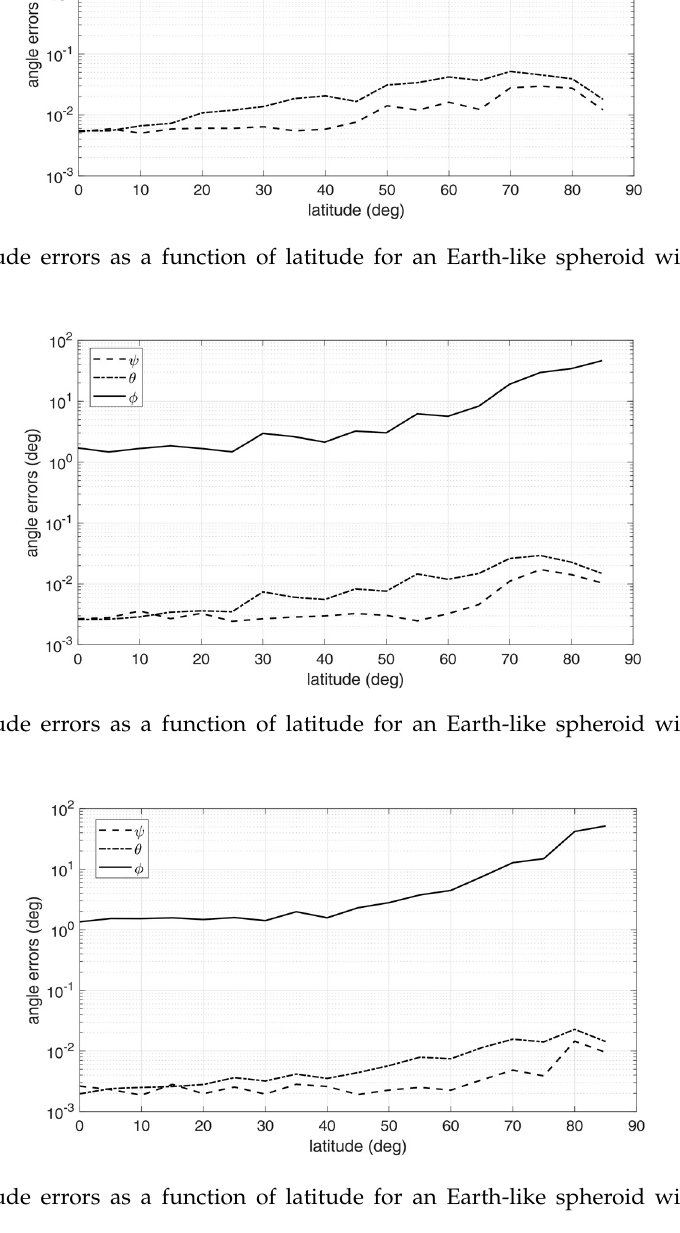
Figure 8. Attitude errors as a function of latitude for an Earth-like spheroid with atmosphere, h / R E = 0.3 [9].